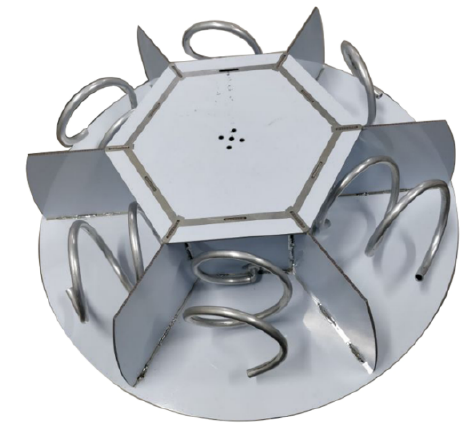
Figure 8. Physical picture of directional spiral antenna array.